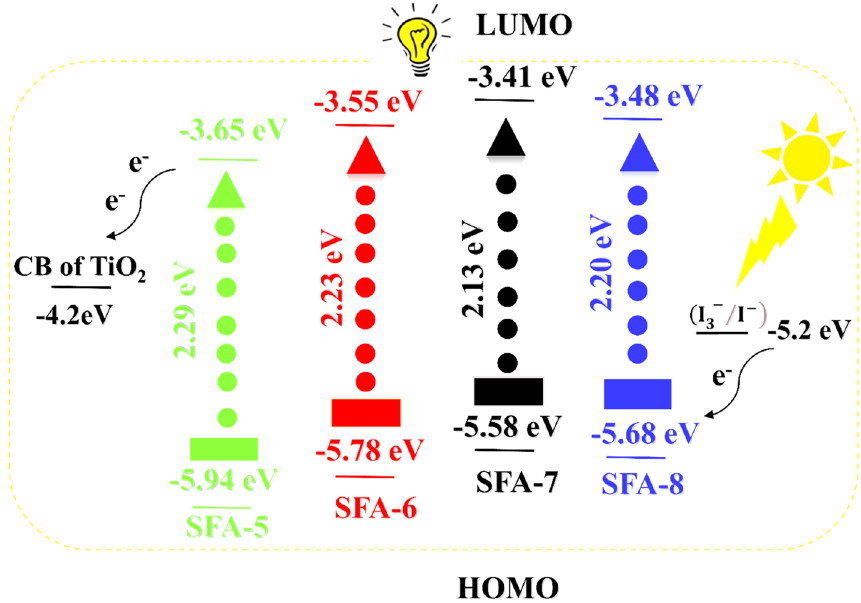
Figure 7. Energy level diagram for SFA-5–8 sensitizers.